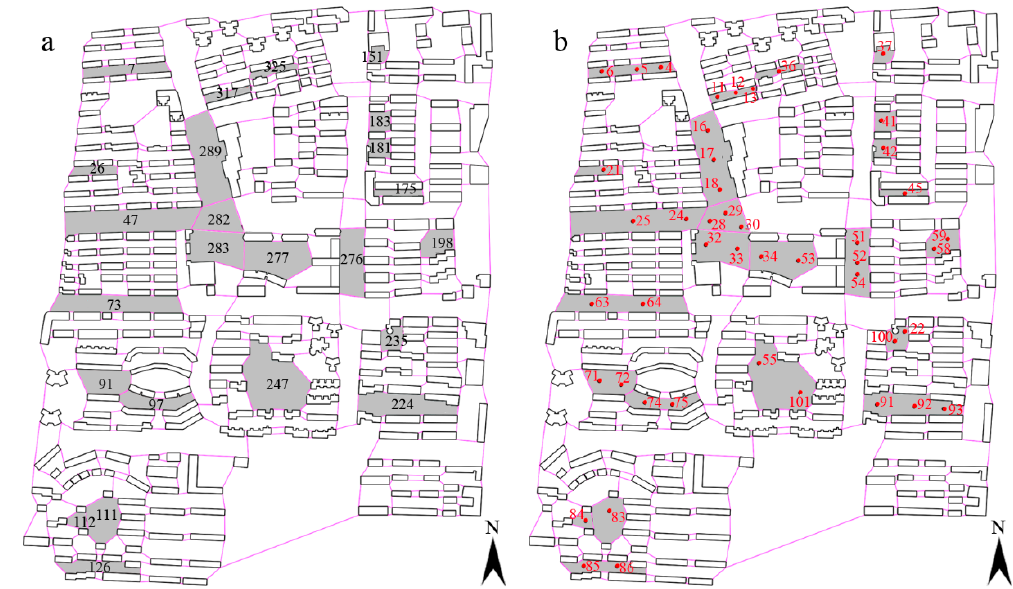
Figure 8. ( a ) The positions of the 24 subspaces. Black numbers are subspace numbers. ( b ) Measurement points located in accordance with the urban spatial characteristics. Red dots are the positions of the measurement points, and red numbers are the measurement point numbers.